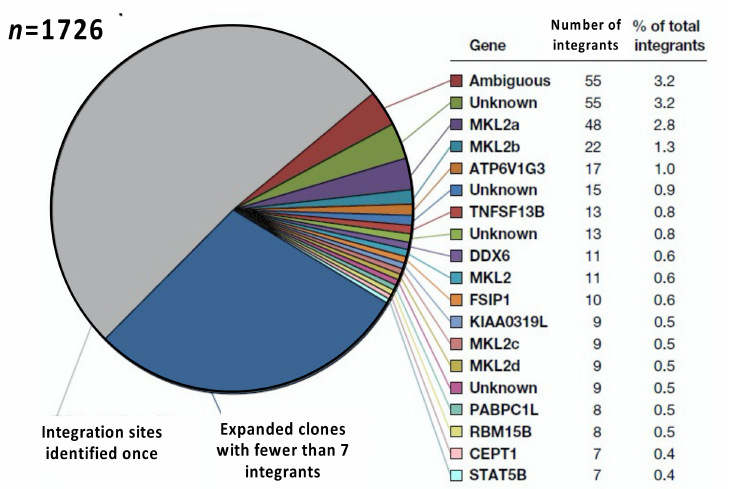
Figure 4. Clonal distribution of integration sites in one individual. The pie chart shows the integration sites obtained from Patient 1 reported by Maldarelli et al. [38], arranged by the relative sizes of the clones, as determined by recovering the same integration site linked to different breakpoints (shown as “number of integrants”). Sites with 7 or more breakpoints are colored and listed by gene on the right. Note that the largest clone, which is labelled “Ambiguous,” and whose provirus is referred to as “AMBI-1” in the text, is integrated in a sequence that is found in multiple locations, including a ribosomal RNA gene, of which there are many nearly identical copies. Data from Maldarelli et al.